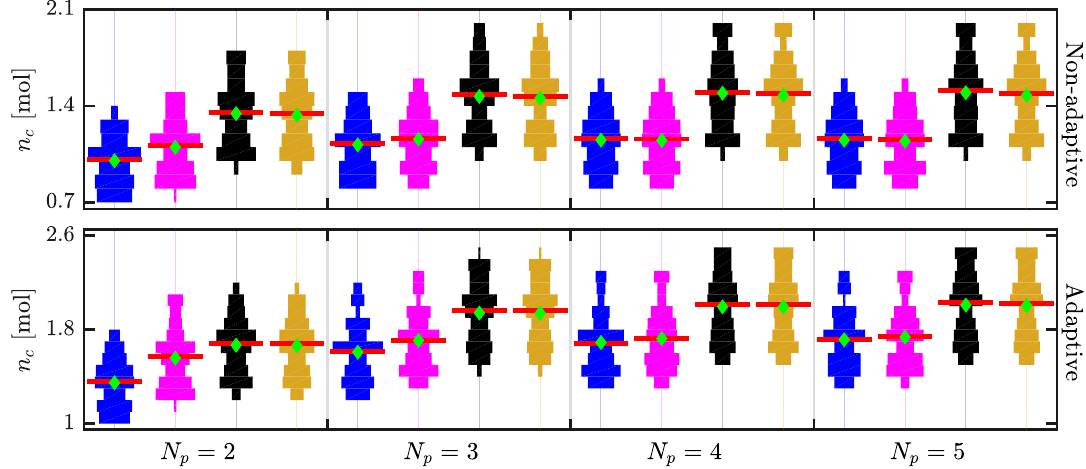
Figure 9. Violin plots of the amount of product C produced in the first 0.3 h in moles using non-adaptive and adaptive NMPC schemes with different lengths of prediction horizon ( N p ) in the absence of measurement noise.